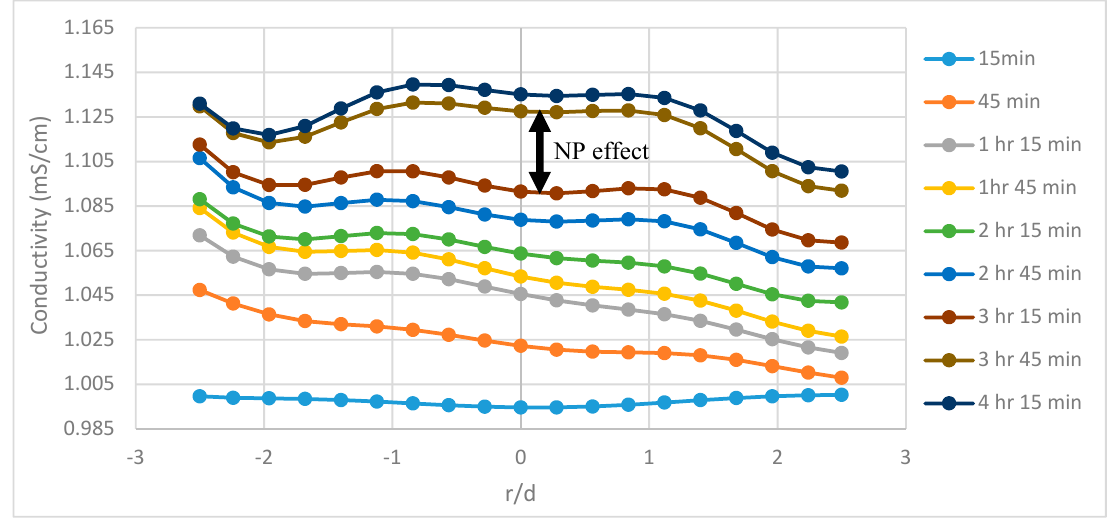
Figure 8. The conductivity profiles for P1 during run no. 1 with 1.0 wt.% SiO 2 , taking the central horizontal region of the tomograms into account. The effects of nanofluid are highlighted with an arrow.